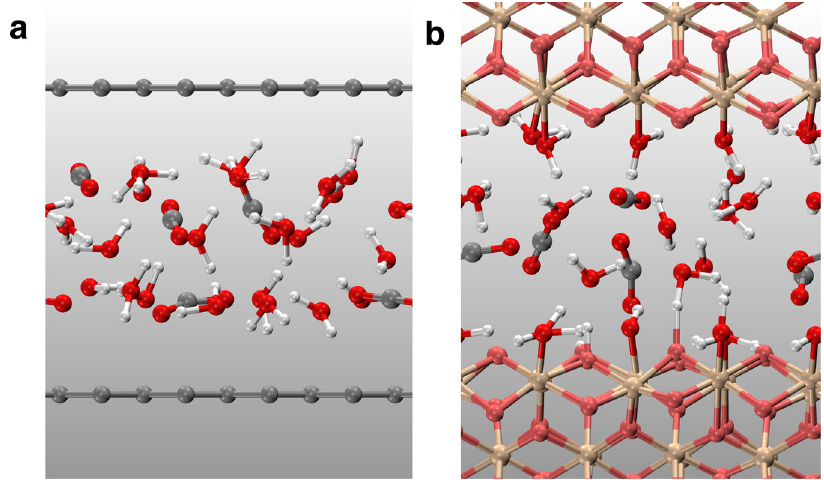
Fig. 1 | Snapshots of ab initio molecular dynamics simulations under con fi ne- ment.a CO 2 (aq)con fi nedbygraphenesheets. b CO 2 con fi nedbycleavedstishovite (SiO 2 )(100)slabs.Redballsrepresentoxygenatomsinsolutions,andpinkballsare